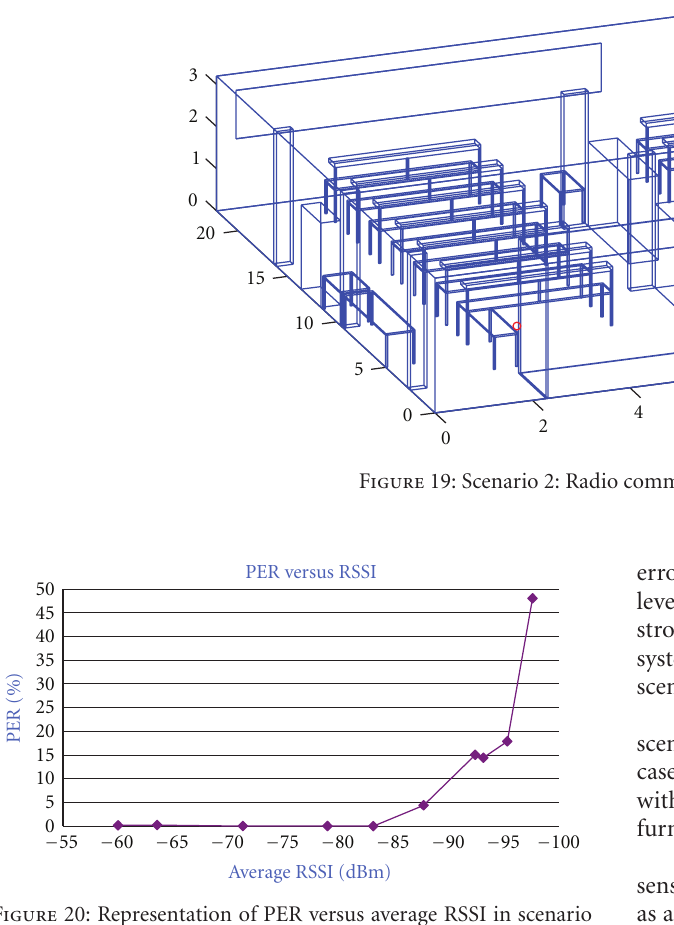
Figure 20: Representation of PER versus average RSSI in scenario